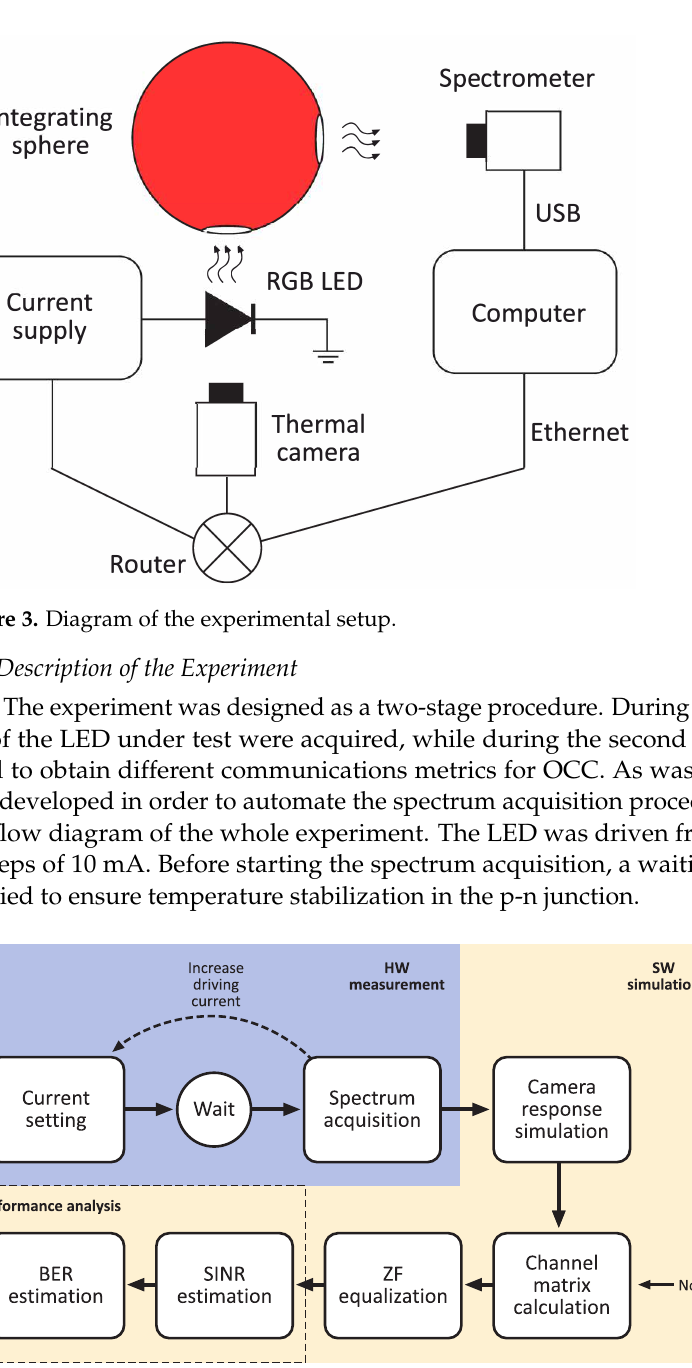
Figure 4. Flow diagram of the experimental